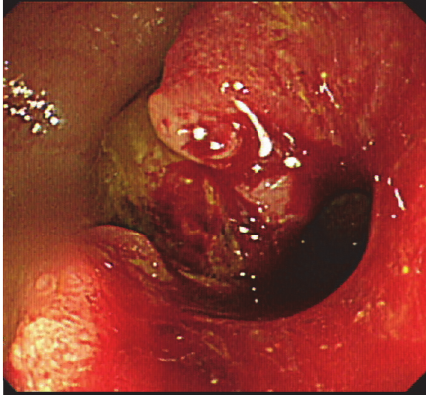
Figure 4: A circumscribed mass with near total obstruction of the sigmoid